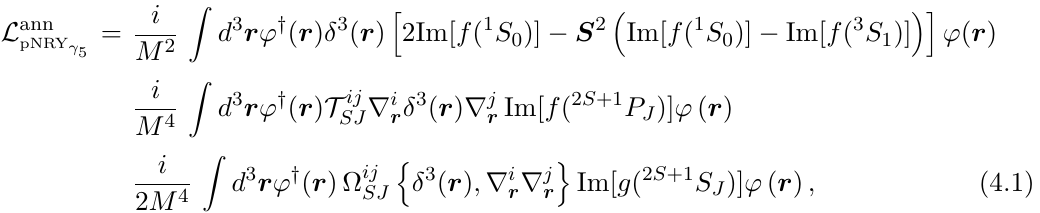
for a scattering state (left) and a bound state 5